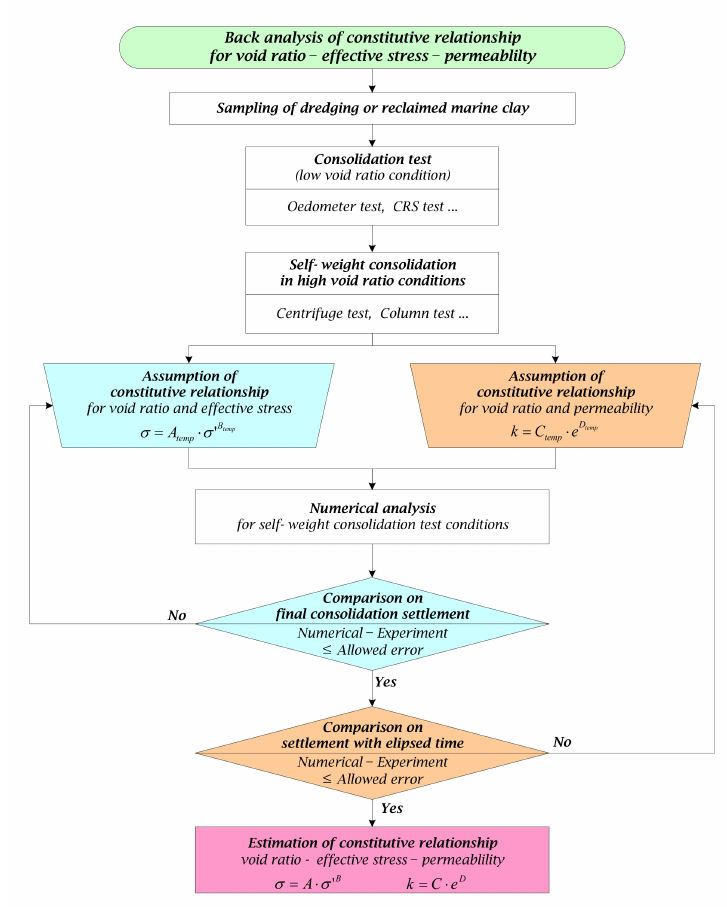
Figure 9. Flowchart of back analysis of constitutive relationship using the centrifugal